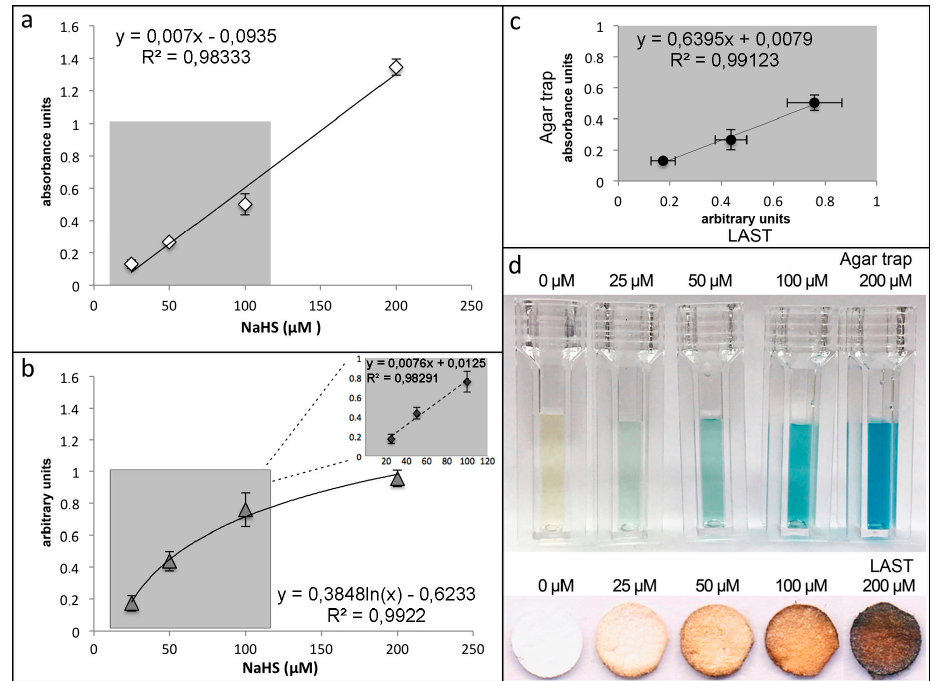
Figure 3. Comparative analysis of efficacy of agar trap and LAST: ( a ) calibration curve of NaHS using agar trap; ( b ) calibration curve of NaHS using LAST where inset (dashed line) shows the calibration curve in the 25-100 μ M NaHS concentration range; ( c ) comparison of the NaHS calibration curves obtained using LAST ( x -axis) and agar trap ( y -axis) methods in the 25–100 μ M NaHS concentrations range; and ( d ) both photographs show reaction products obtained of H 2 S, detected with agar trap developed by methylene blue staining (top), or lead acetate treated filters (bottom). LAST, lead acetate strip test.